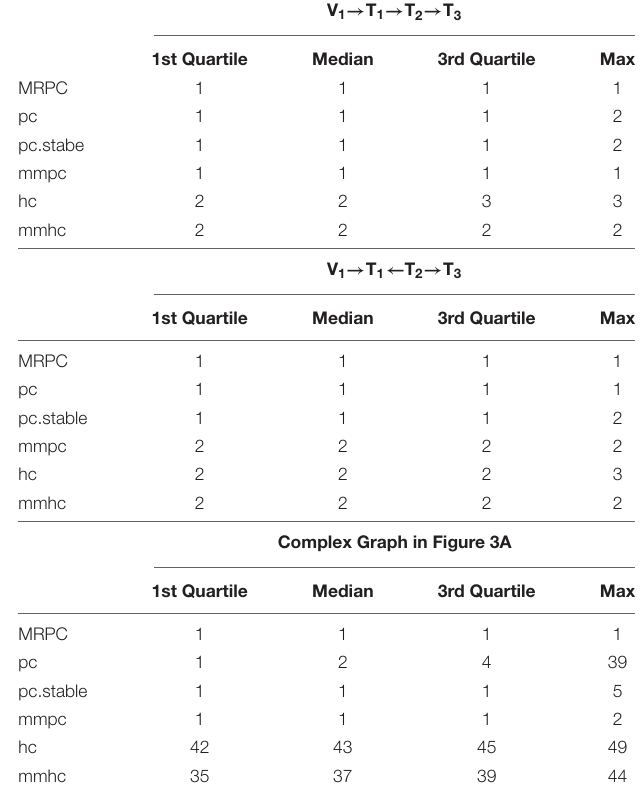
The complex graph ( Figure 3A ) For each graph, 1,000 independent data sets were simulated with a sample size of 500 and signal strength of 0.5.All jobs were run on a Mac computer with a CPU of 2.2 GHz and RAM of 16